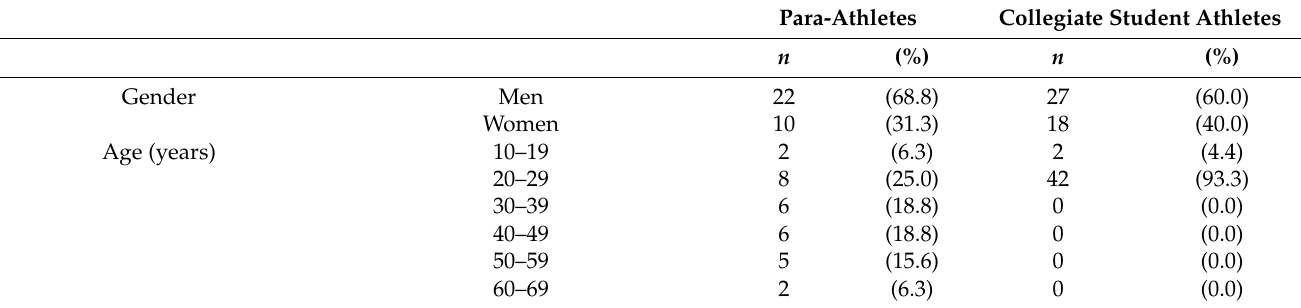
Table 3. Characteristics of the